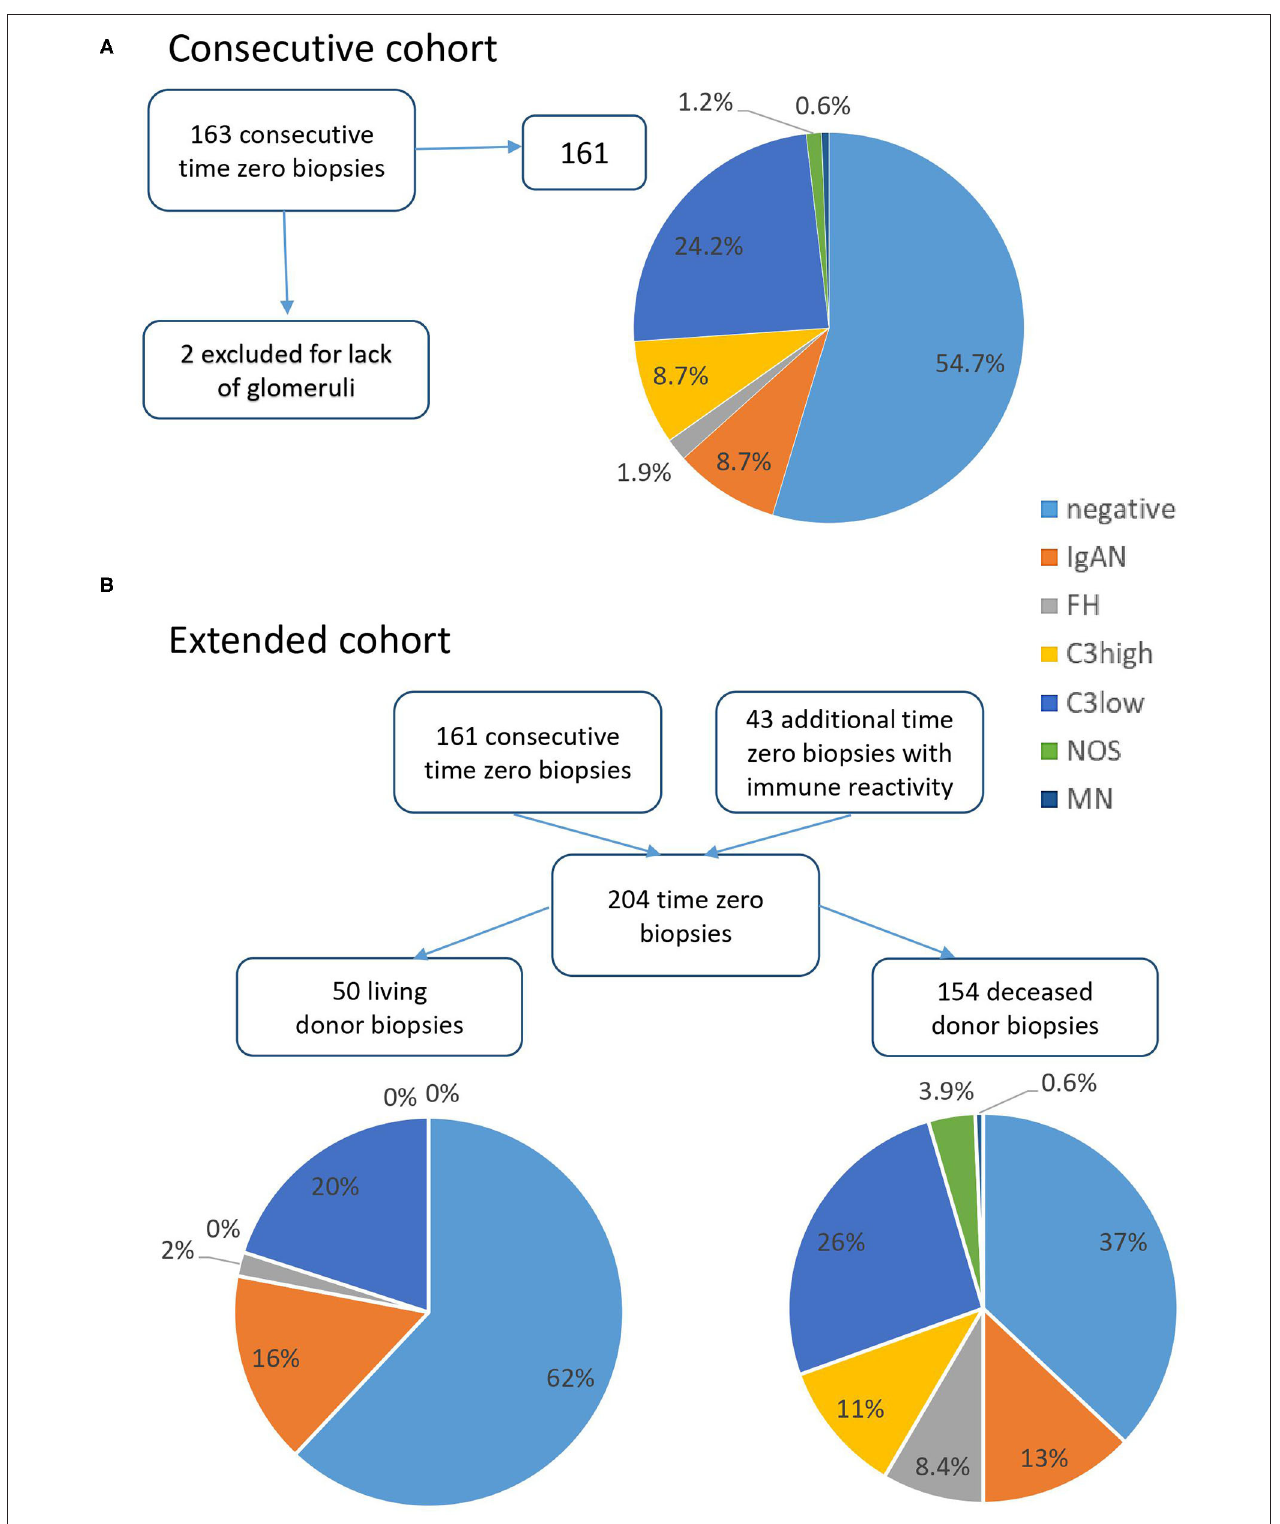
FIGURE 1 | Relative distribution of immune pattern in time zero biopsies. (A) In the consecutive cohort 161 time zero biopsies were analyzed after exclusion of two cases with insufficient material. Over half of the cases showed no significant immune reactivity, about a quarter of cases mild C3 deposits (C3low) and the remainder different immune patterns including IgA, fullhouse (FH), and C3high. (B) Comparing living and deceased donor biopsies in the total cohort of 204 time zero specimens, negative cases were more prevalent in living donor organs and C3high staining was only observed in deceased donor transplants.